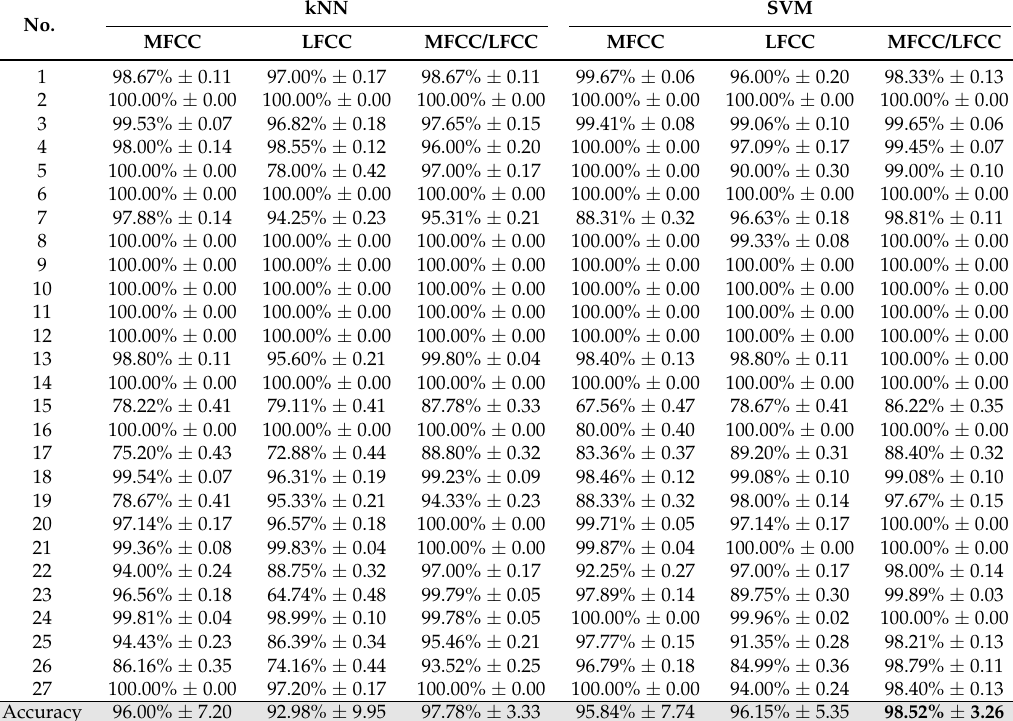
Table 2. Classification results. kNN: K-Nearest Neighbors; LFCC: Linear Frequency Cepstral Coefficient; MFCC: Mel Frequency Cepstral Coefficient; SVM: Support Vector